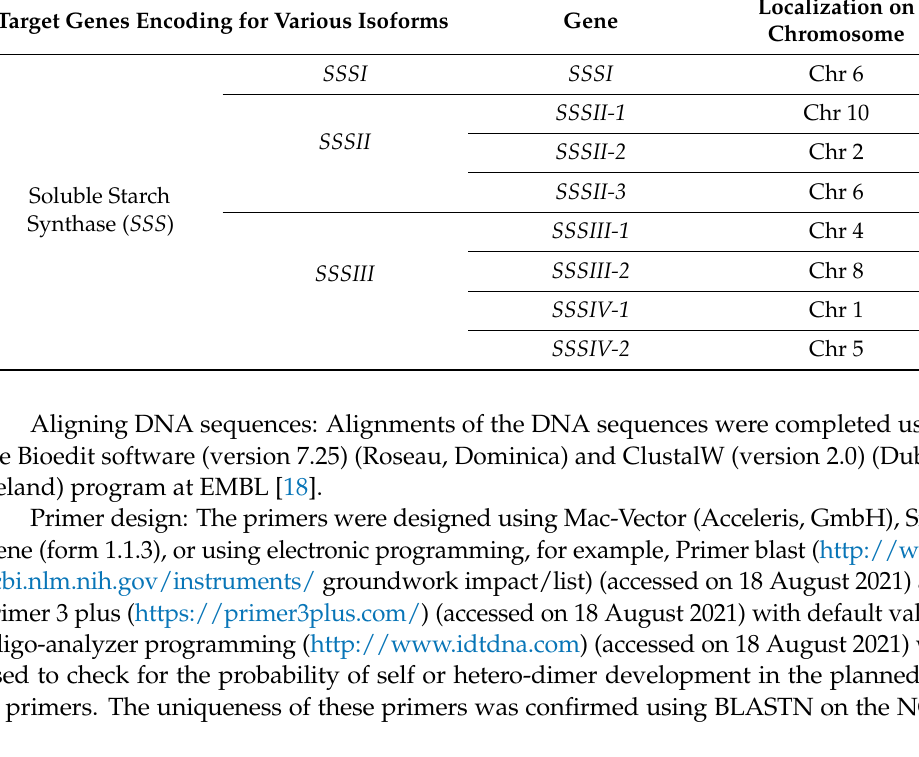
Localization on Chromosome